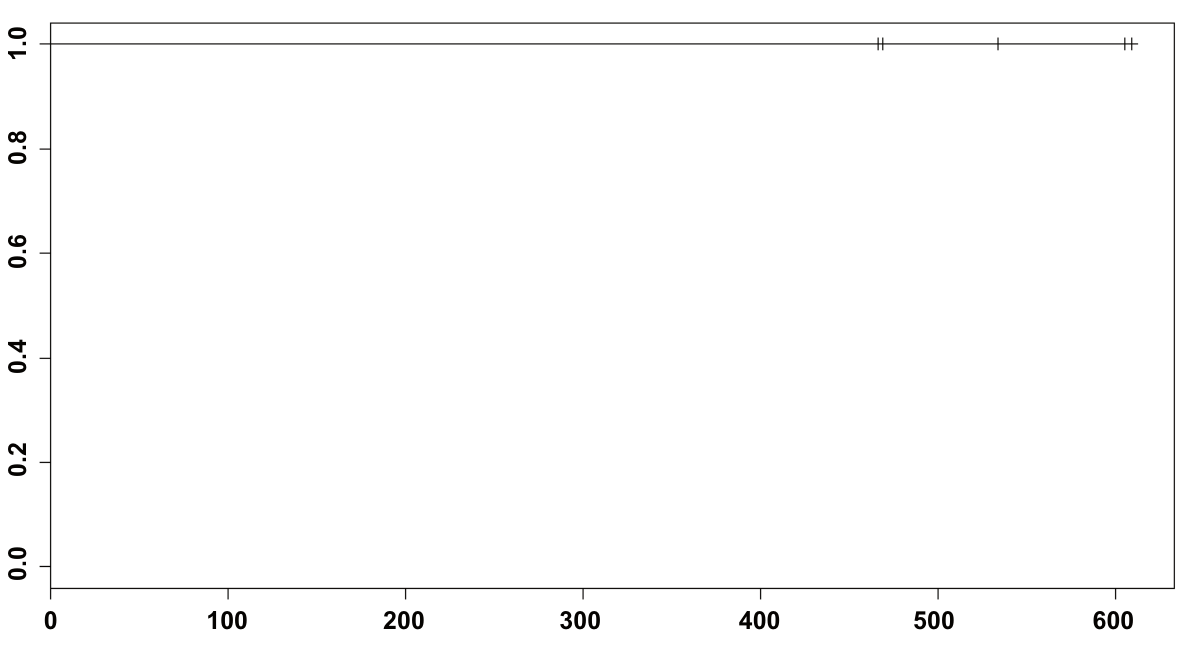
Figure 18. Actual survival curve for 5 patients with peritoneal carcinomatosis from colorectal origin who were treated at a maximal temperature lower than 39°C.